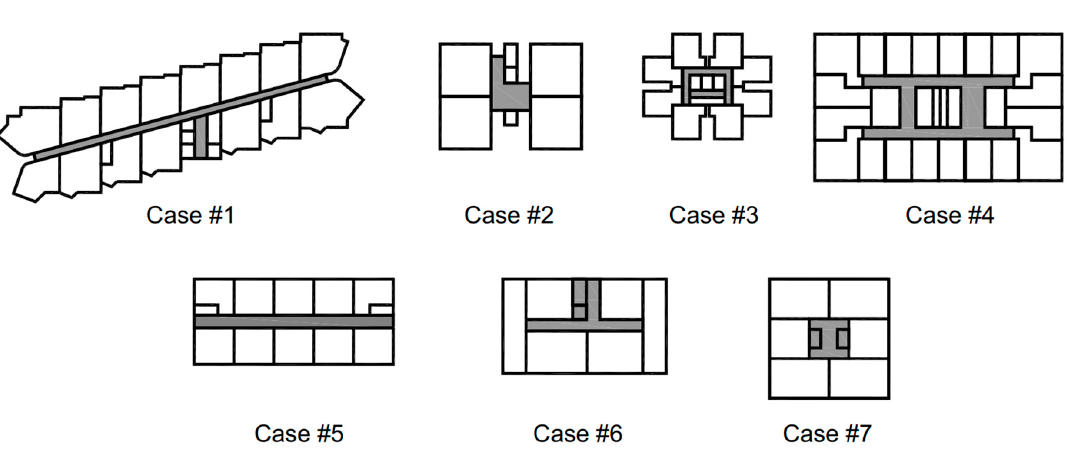
Figure 2. Floor plans of case studies.